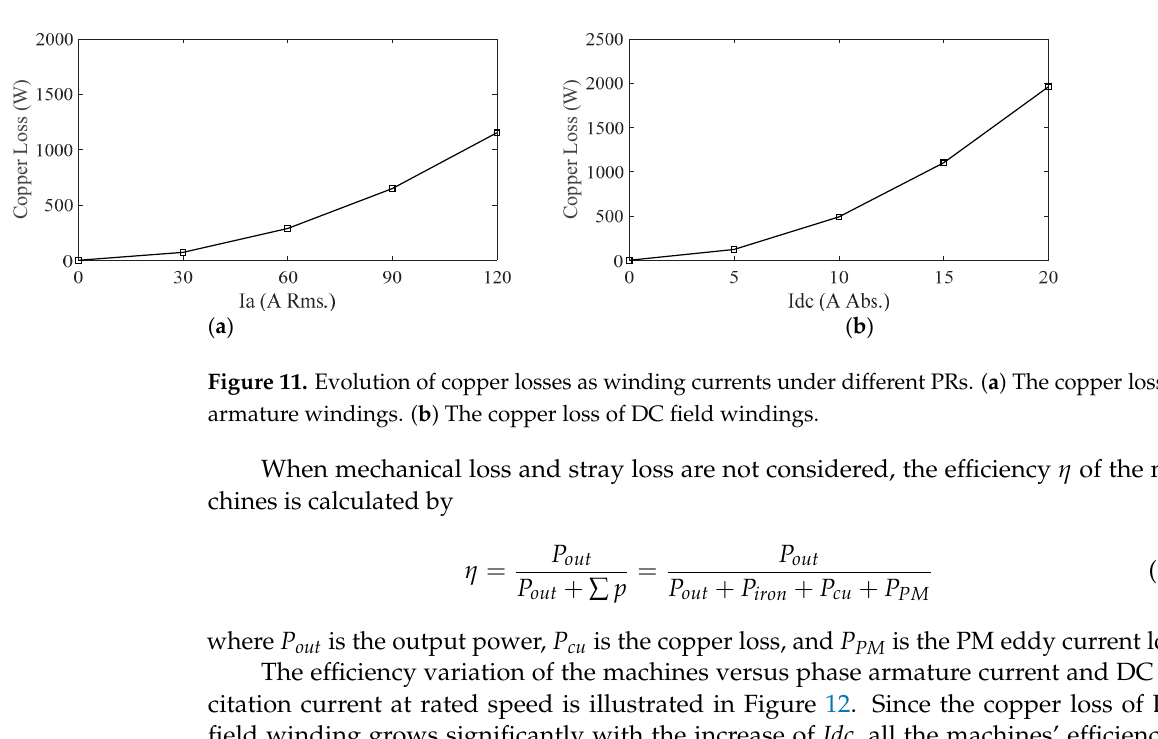
Figure 12. Evolution of efficiency as armature winding currents under different PRs at rated speed. ( a ) PR of 8/1. ( b ) PR of 17/1. ( c ) PR of 35/1.